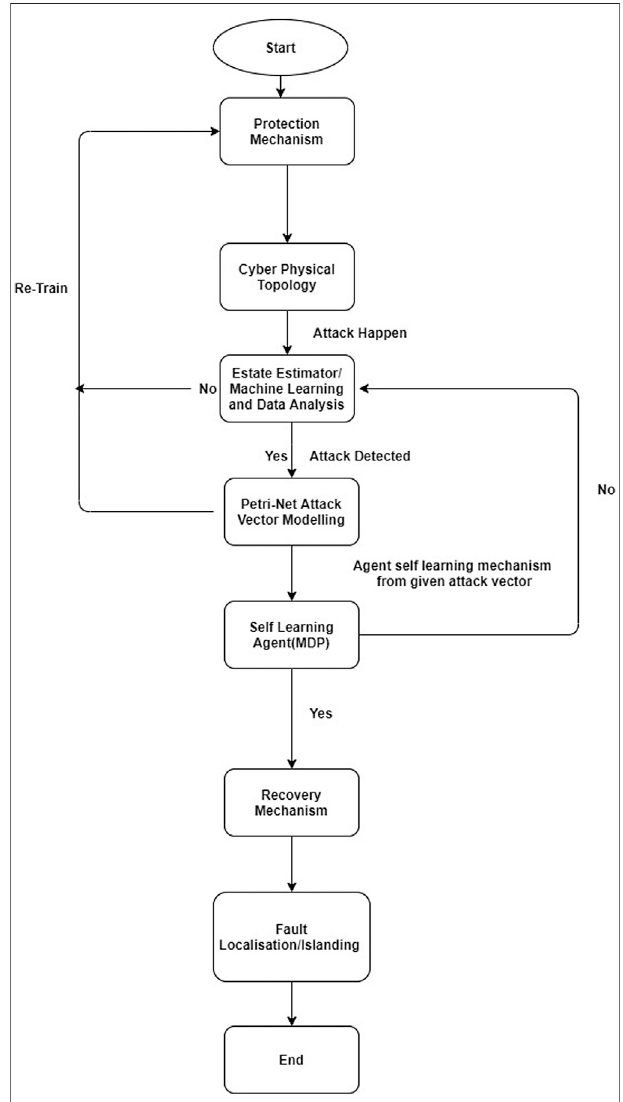
FIGURE 5 | Flow chart for cyber physical defense